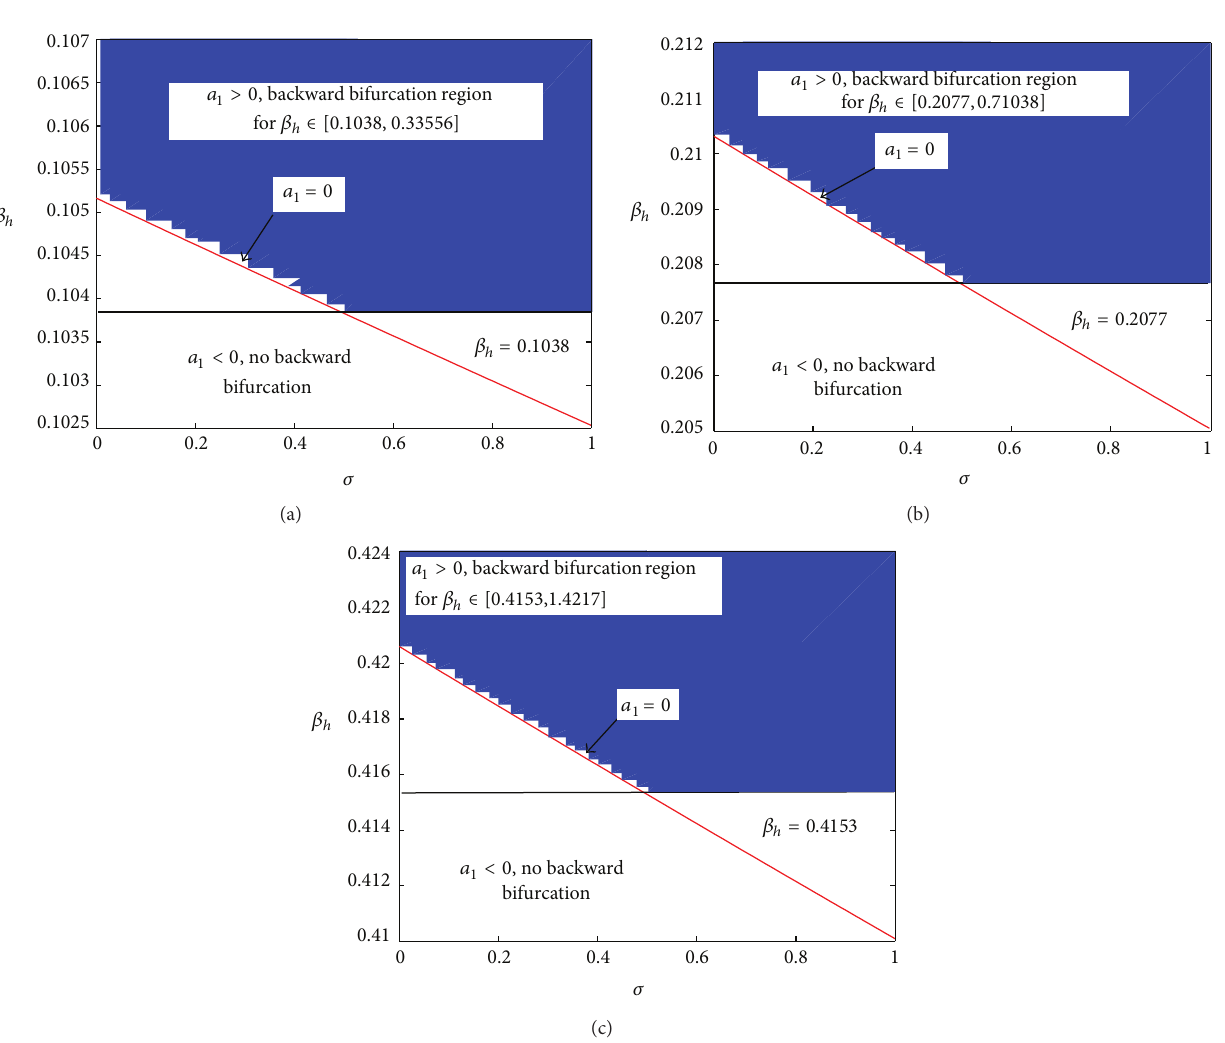
Figure 2: Backward bifurcation regions for the model (4) in the 𝜎 - 𝛽 ℎ parameter space corresponding to 𝜎 = 0.5 and various ranges of 𝛽 ℎ . Parameter values used are: Λ ℎ = 30, Λ 𝑣 = 24, 𝛿 ℎ = 0.2, 𝛾 ℎ = 0.0005, 𝜇 ℎ = 0.00004, 𝑏 = 0.4, 𝜇 𝑣 = 0.0.015, 𝛽 𝑣 = 0.09 . In (a) 𝜇 𝑣 = 0.05, ℜ 0 = 0.0014046 (backward bifurcation region for 𝛽 is 𝛽 ℎ ∈ [0.2077, 0.71083]) , and (c) 𝜇 𝑣 = 0.2, ℜ 0 = 0.0000087788 (backward bifurcation region for 𝛽 ℎ is 𝛽 ℎ ∈ [0.4153, 1.9468]) . With the above set of parameter values, 𝑎 1 > 0, 𝑏 1 > 0 , and ℜ 0 < 1